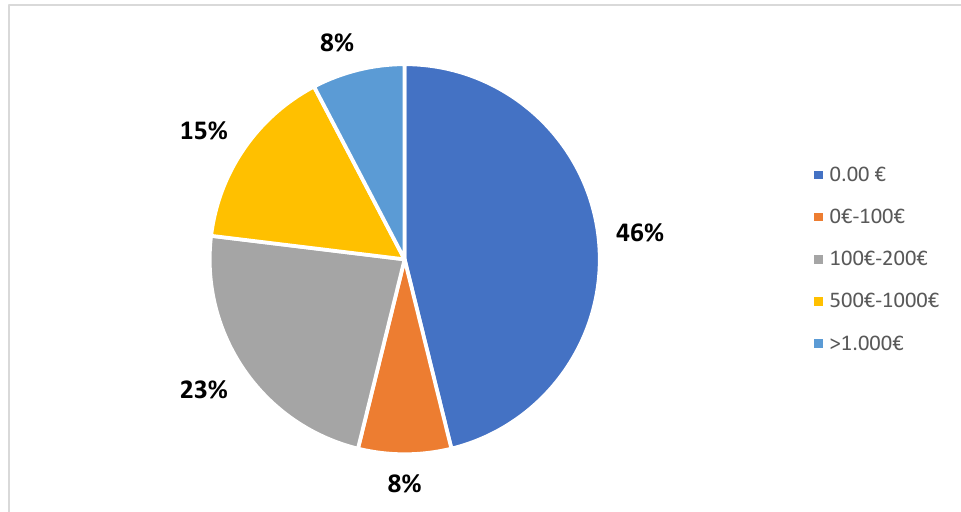
Figure 19. Amount accepted for the installation of chargers.